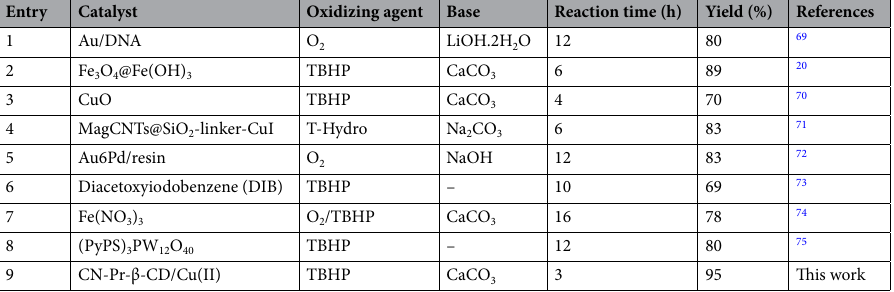
Table 4. Comparison between the catalytic efficiency of the CN-Pr-β-CD/Cu(II) with the reported catalysts for the amide syenthesis through the oxidative amidation of benzyl